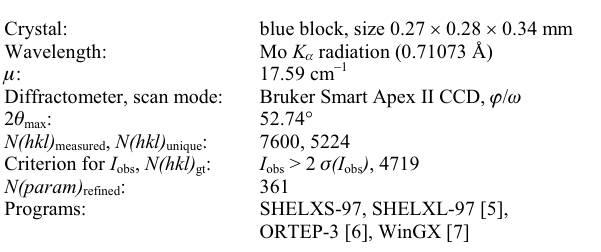
Table 1. Data collection and handling.